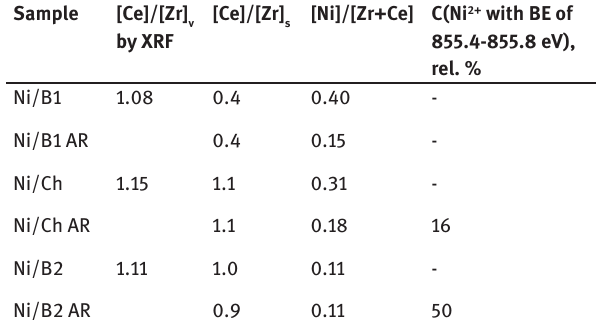
Table 3: Atomic ratios of elements and relative Ni content in the near-surface layers of catalysts by XPS